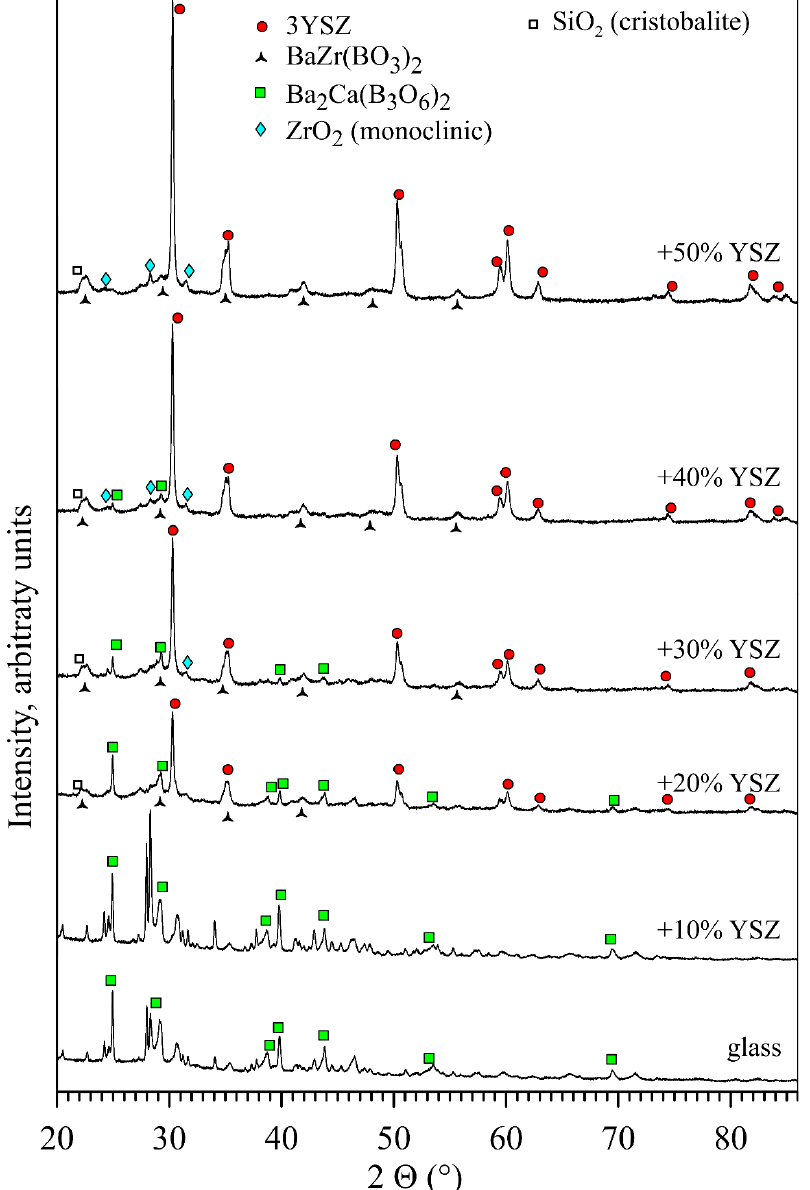
Figure 7. XRD patterns of the glass and composite samples containing 10–50 wt.% YSZ after the thermal treatment cycle.